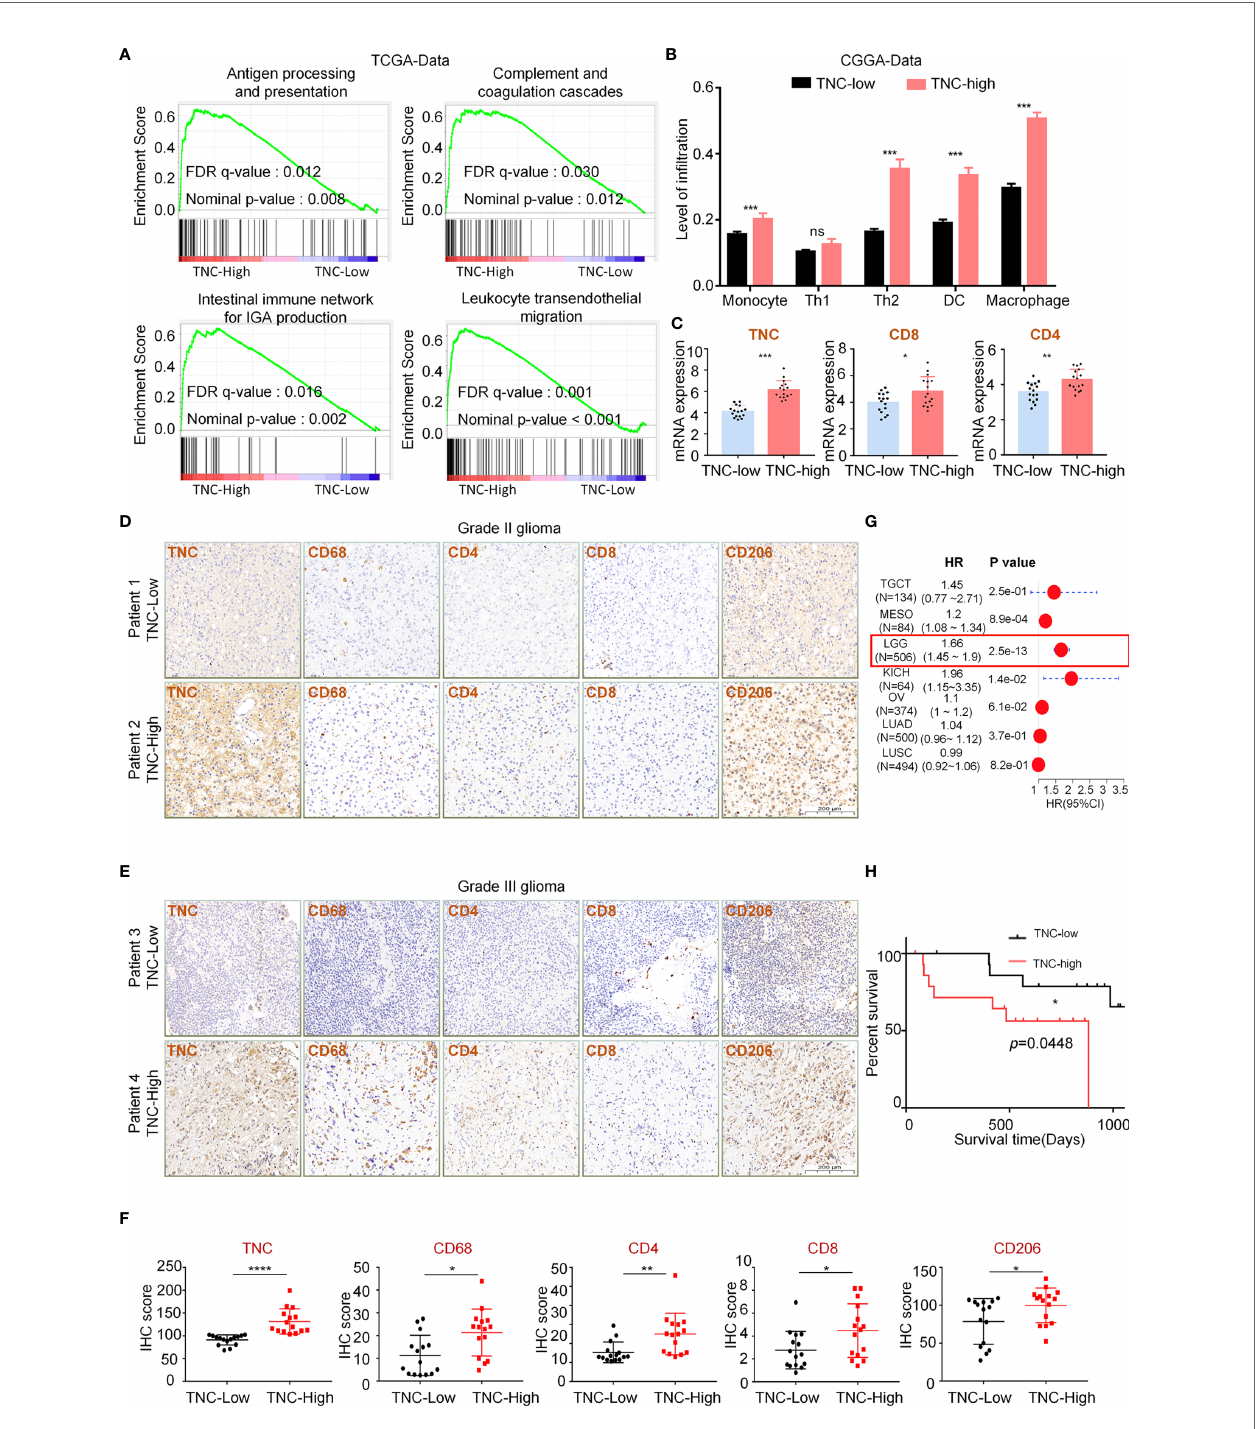
FIGURE 2 | TNC was associated with LGGs immune microenvironment (A) Functional gene-set enrichment analysis of TNC used TCGA transcriptome data. (B) Histogram describing the level of immune cell in fi ltration as calculated by using the ImmuCellAI theory in different TNC expression groups. (*** p < 0.001, ns, not signi fi cant) (C) qRT-PCR analysis of mRNA expression of CD4 and CD8 and TNC in 32 LGG specimens grouped by TNC mRNA level. (* p < 0.05; ** p < 0.01; *** p < 0.001) (D, E) IHC staining of TNC, tumor-associated macrophages markers (CD68 and CD206), and T cell markers (CD4 and CD8) in grade II (D) and grade III (E) LGG specimens. Representative images are shown. (Scale bars = 200 um ) (F) Scatter plot showing the distribution of CD68, CD206, CD4 and CD8 IHC scores (H- SCORE) in the two subgroups grouped based on the median of the TNC staining score. (* p < 0.05; ** p < 0.01; *** p < 0.001, **** p < 0.0001, n = 30) (G) The forest plot showing the single-factor logistic regression analysis of the prognosis of TNC in TCGA pan-cancer data. (LGG: HR=1.66) (H) Kaplan-Meier curve depicting the clinical value of TNC in 30 LGG patients with follow-up information. (* p <